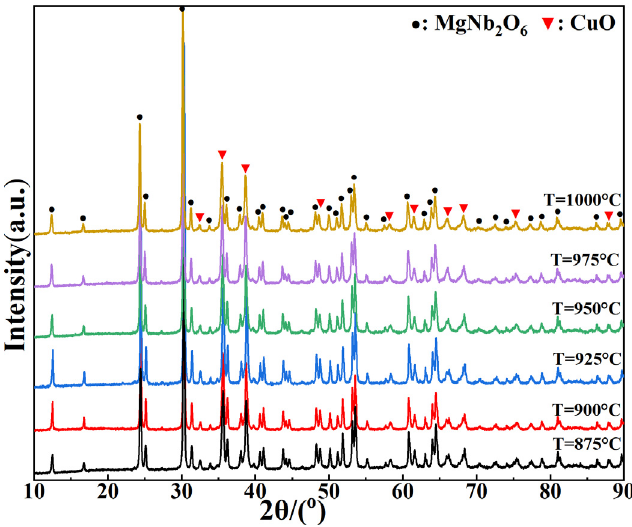
Figure 1. XRD patterns of MgCu 2 Nb 2 O 8 ceramics sintered at different temperatures.